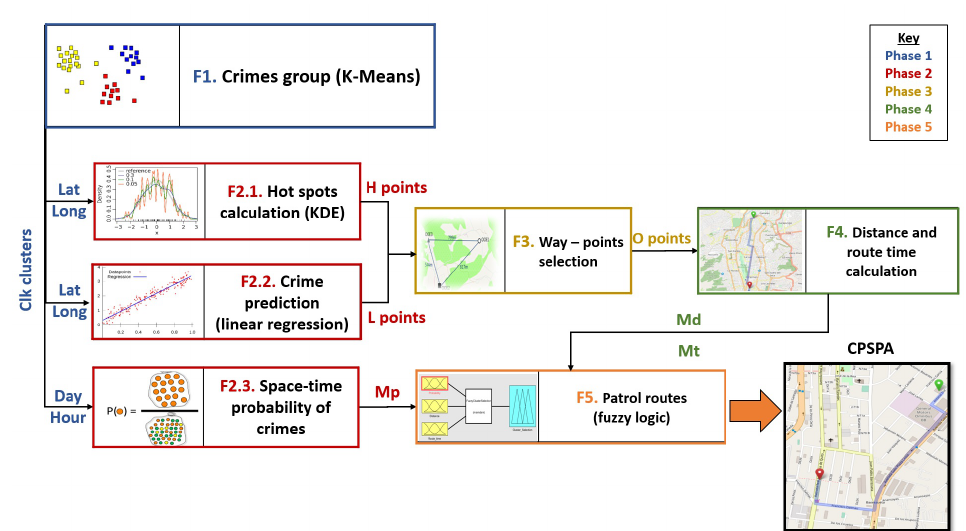
Figure 5. Diagram of Smart Patrol and Crime Prediction Algorithm.